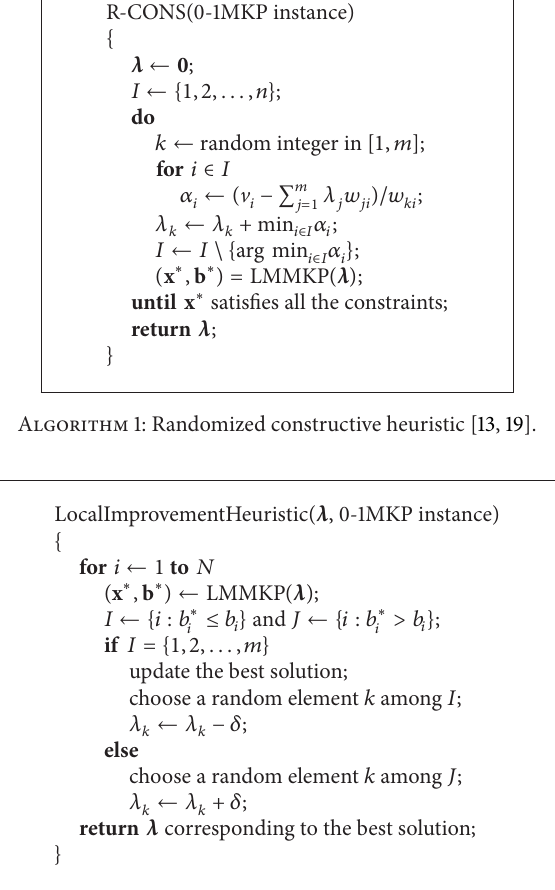
Algorithm 2: Local improvement